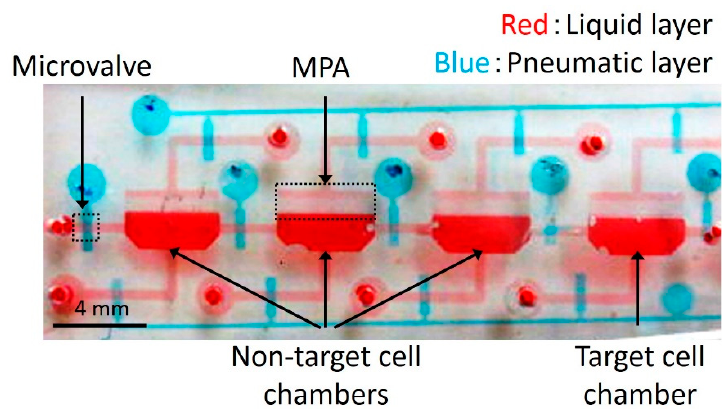
Figure 2. Photograph of the fabricated microfluidic device. The liquid layer was filled with red dye and the pneumatic layer blue dye.